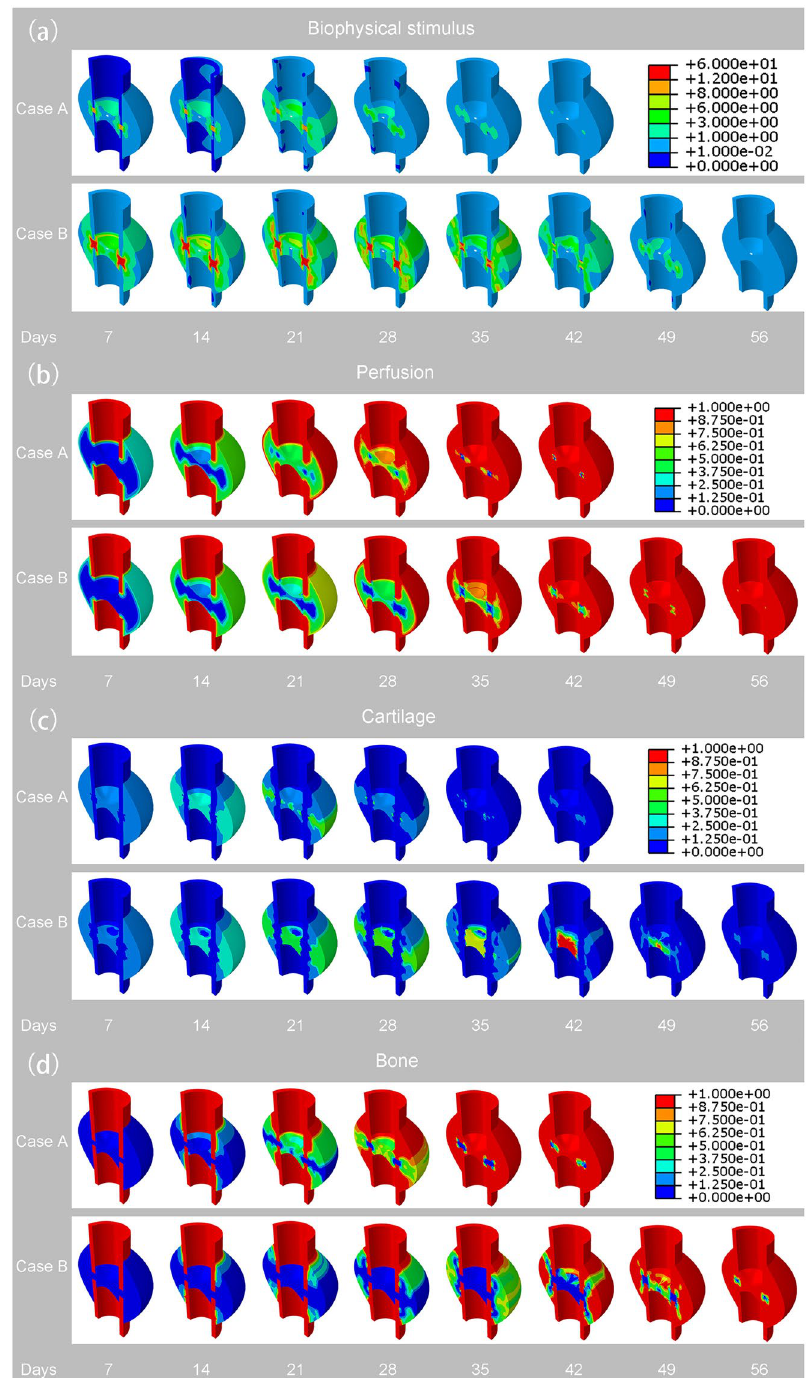
Figure 2. ( a ) Predicted biophysical stimulus for both cases A and B at an interval of 7 days. ( b ) Predicted perfusion for both cases A and B at an interval of 7 days. ( c ) Predicted cartilage concentration for both cases A and B at an interval of 7 days. ( d ) Predicted bone concentration for both cases A and B at an interval of 7